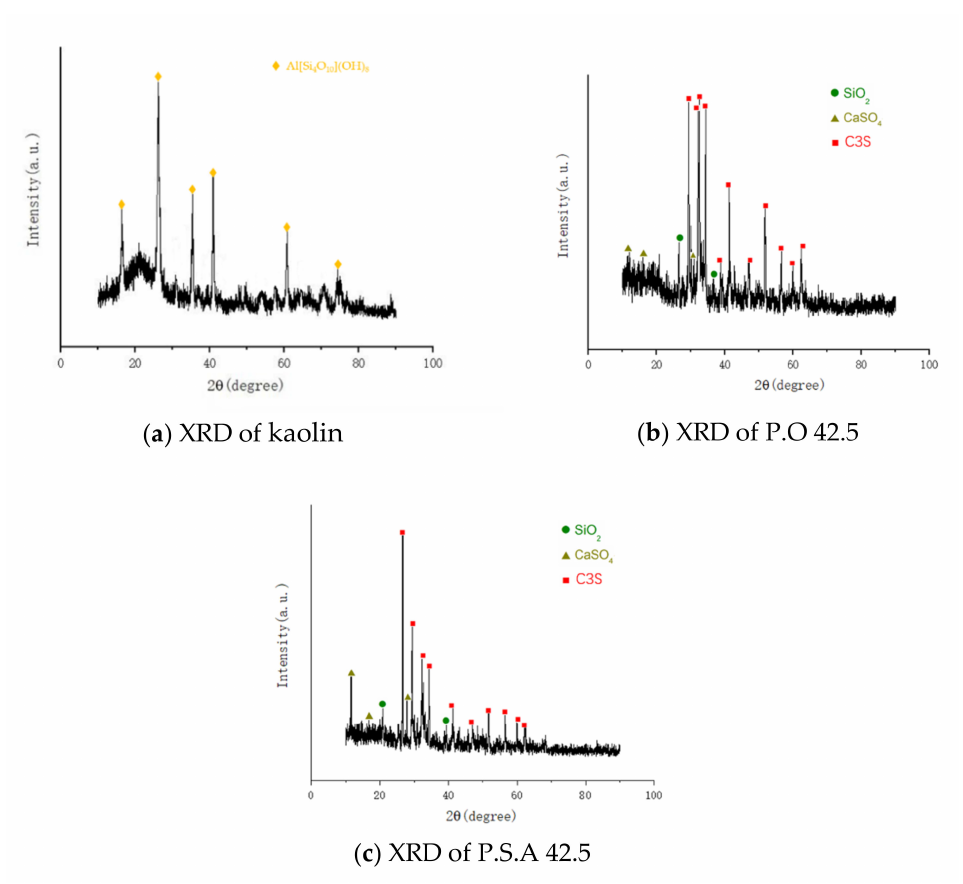
Figure 1. XRD of raw